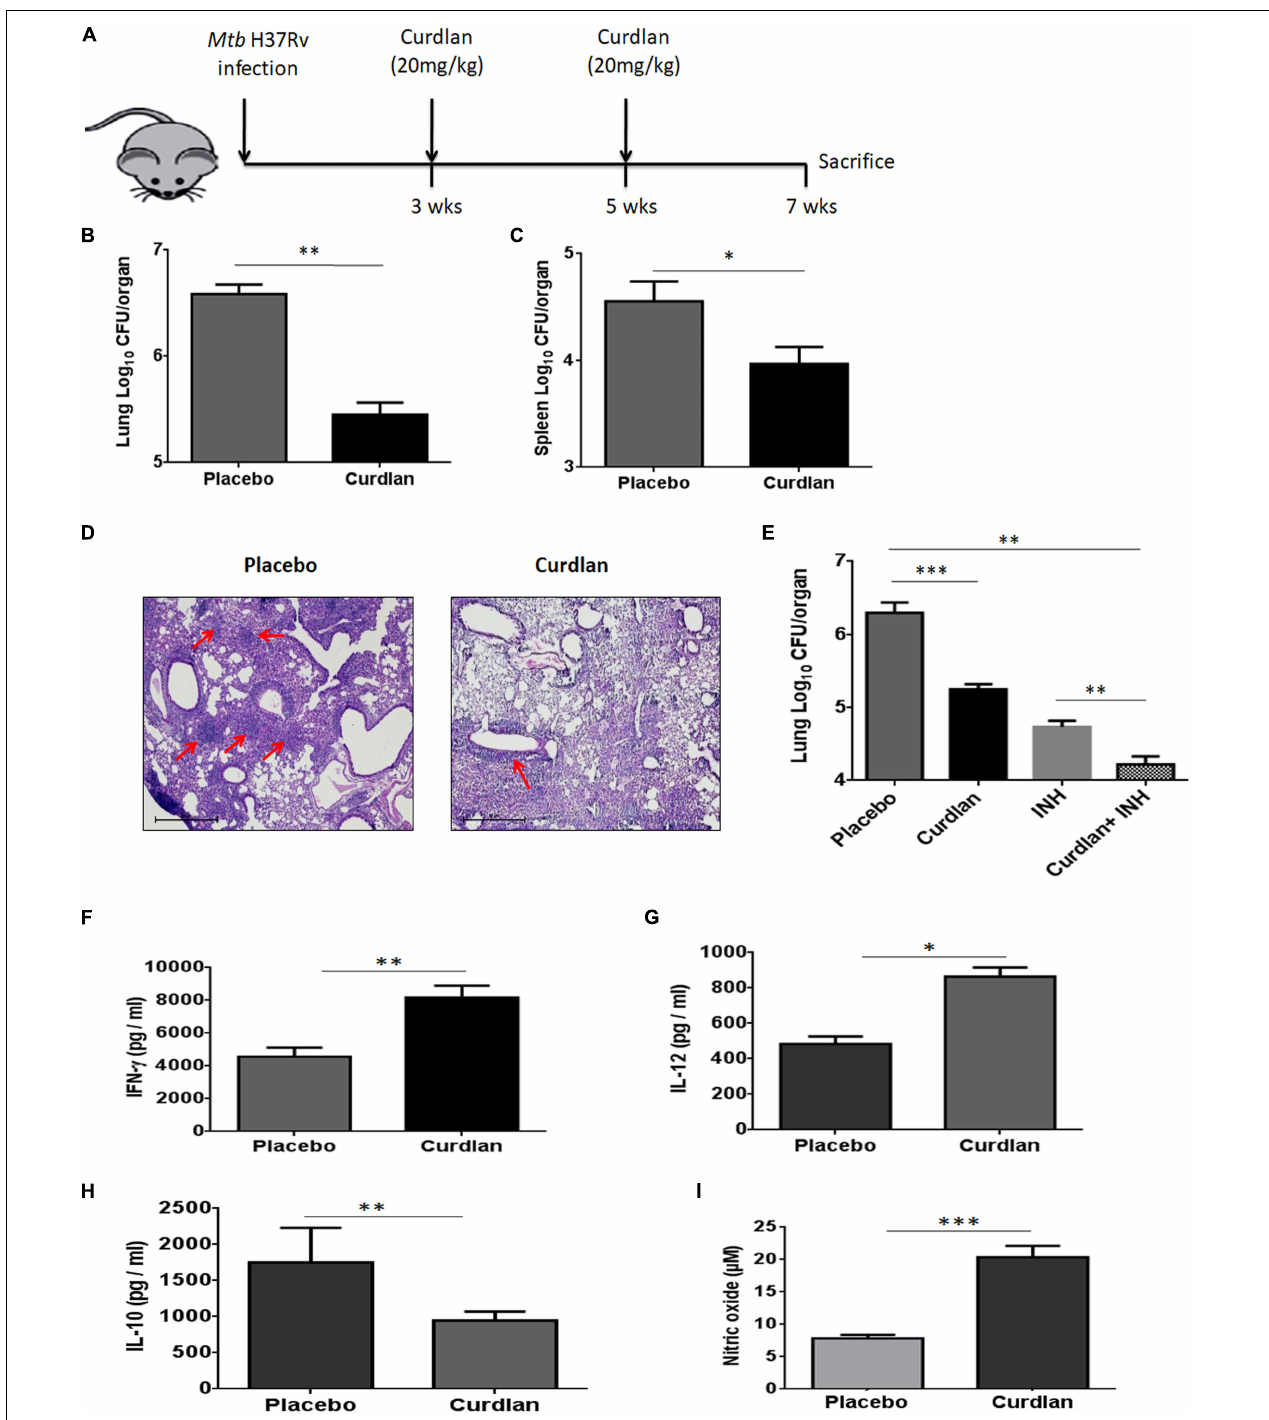
FIGURE 4 | Administration of curdlan reduces the Mtb burden in the mouse model of TB. (A) Mice were aerosol challenged with Mtb ( ∼ 100 CFU) followed by subcutaneous administration of curdlan (20 mg/kg) after 21 days of infection. Curdlan was administered twice after the gap of 2 weeks. After 7 weeks of Mtb infection, animals were sacrificed and (B,C) Mtb burden in (B) lung and (C) spleen was enumerated by CFU assay. (D) Photomicrographs (40 × ) of hematoxylin and eosin stained lung sections; arrows depict the number of granulomas per field. (E) Mtb infected mice were administered curdlan in combination with anti-TB drug [isoniazid (INH), 25 mg/kg body wt] twice as described above. After 7 weeks post infection, mycobacterial load in the lungs were enumerated by CFU assay. (F–I) Lung cells from placebo and curdlan treated mice were cultured in the presence of PPD (25 µ g/ml) for 48 h and thereafter supernatant was assessed for the levels of (F) IFN- γ ; (G) IL-12; and (H) IL-10 by ELISA. Further, (I) Nitric oxide levels were quantified by Griess assay. Data are represented as mean ± SD of two independent